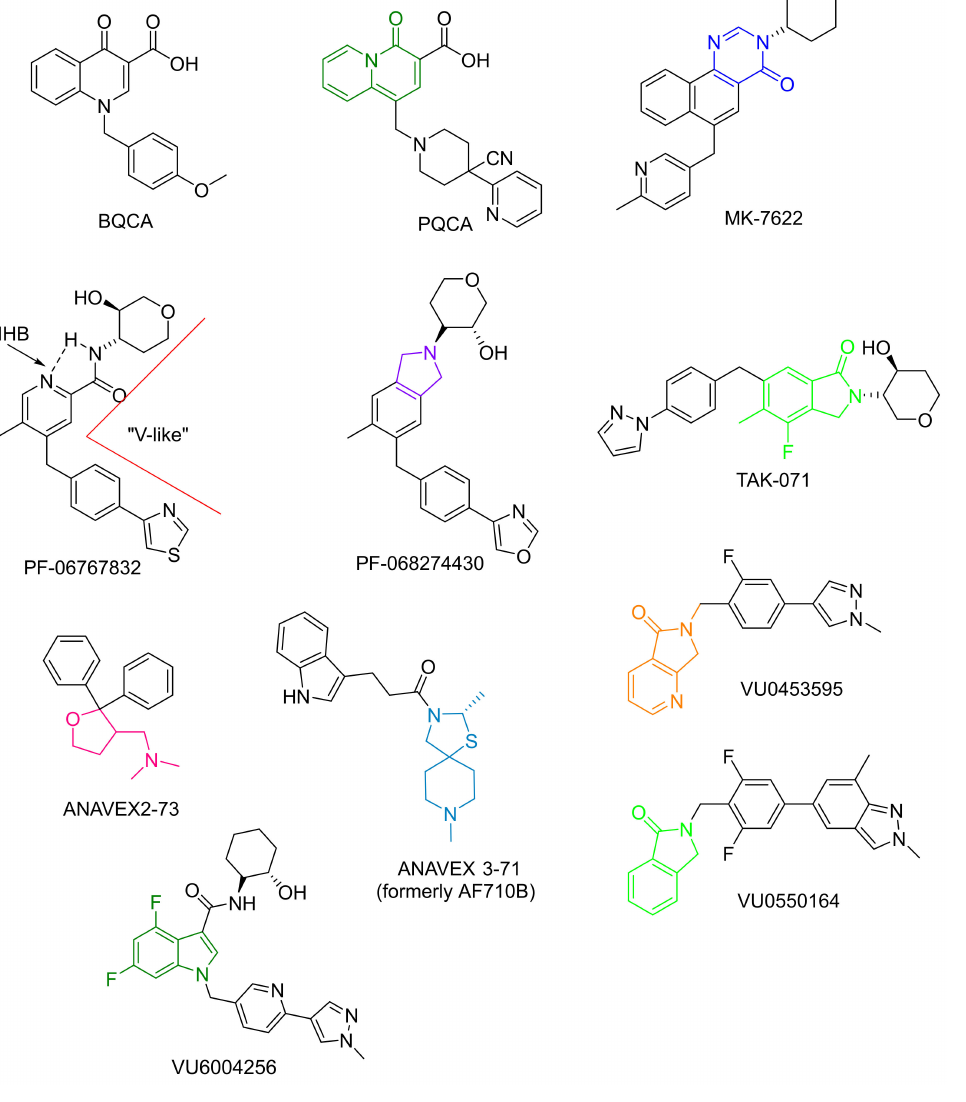
Figure 4. Recent designs of allosteric modulators (primarily) targeting the M 1